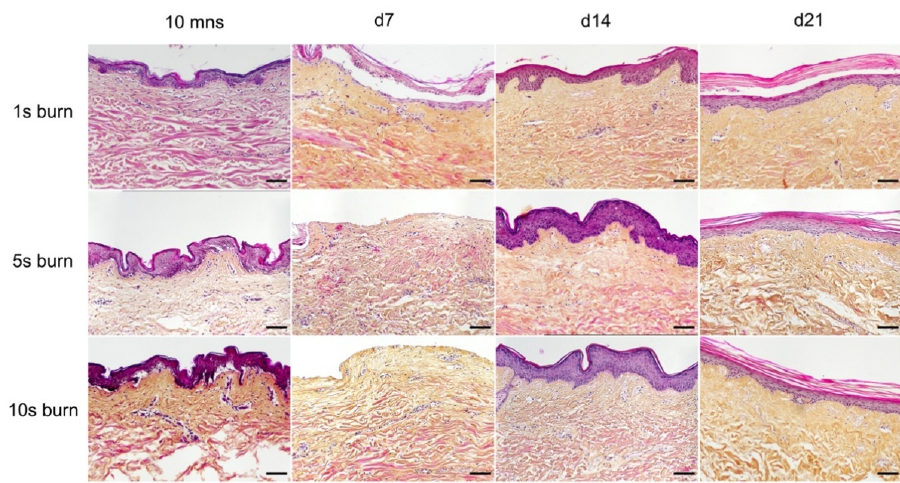
Figure 3. Assessment of burn duration impact on epidermal integrity in ex vivo cultured human skin explants. Hematoxylin phloxine saffron (HPS) staining was performed on human skin explants